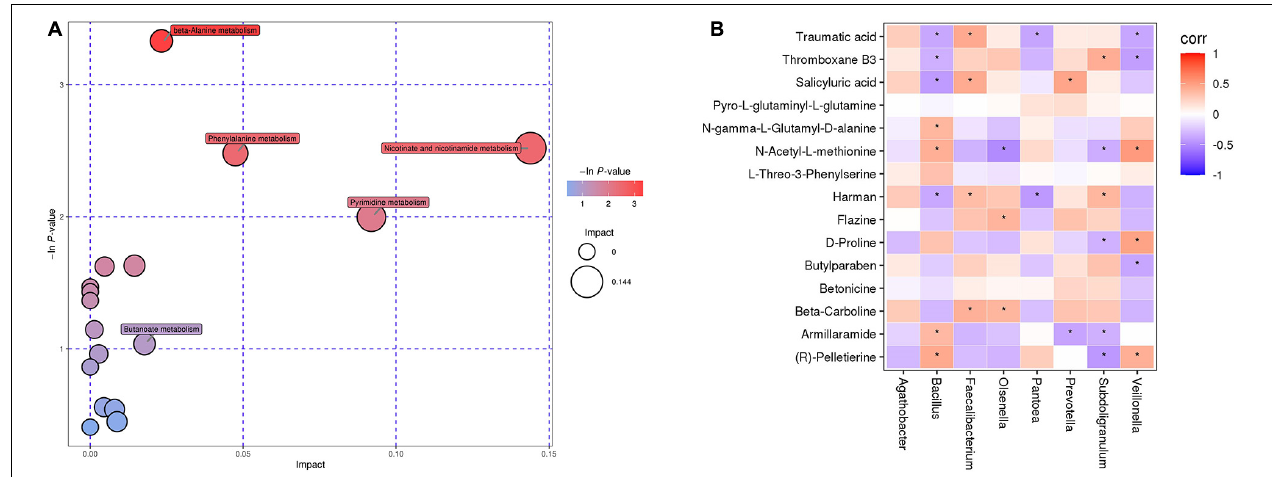
FIGURE 4 | (A) Bubble chart of differential metabolic pathways between DR patients and healthy controls. Each bubble in the bubble chart represents a metabolic pathway. (B) The relationship between gut microbiota and fecal metabolites in patients with DR. Red indicates that the flora is positively correlated with metabolites, and purple indicates that the flora is negatively correlated with metabolites. “*” indicates a significant difference between the two groups ( p -value < 0.05).